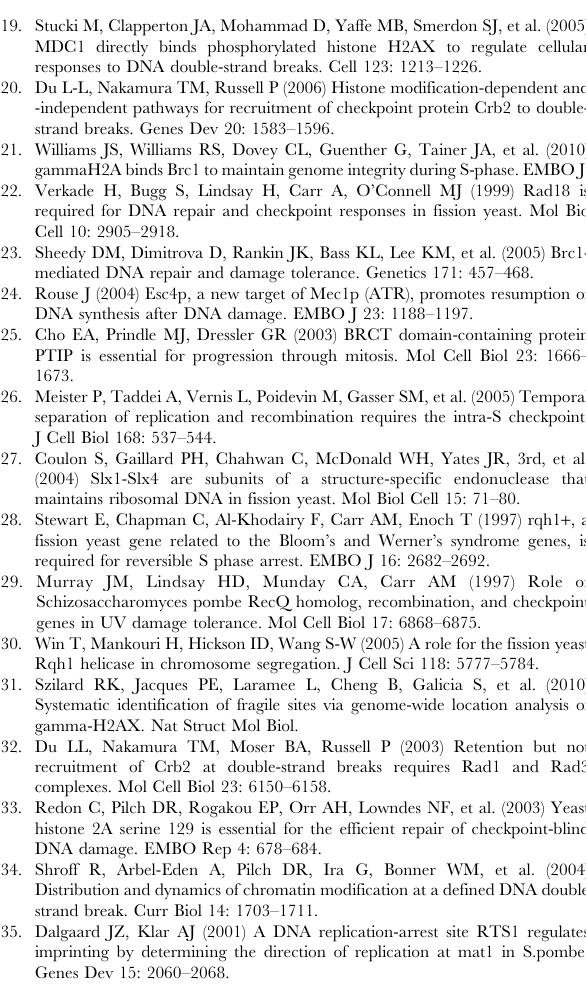
Figure S4 Absence of c H2A does not affect cohesin levels at the centromeres and telomeres. ChIP-qPCR analysis of Rad21-3HA was performed in wildtype and htaAQ mutants, and an untagged strain was used as a negative control. Cells were synchronized using cdc25-22 block and release and ChIP samples were collected in S-phase, as determined by septation index. Figure S5 Taz1 distribution in the telomeres. ChIP-qPCR analysis of Taz1-3HA was performed in asynchronous wildtype cultures and an untagged strain was used as a negative control. Primers are described in the text. Table S1 List of all genes and features containing phospho-H2A in the ChIP-on-Chip analysis.